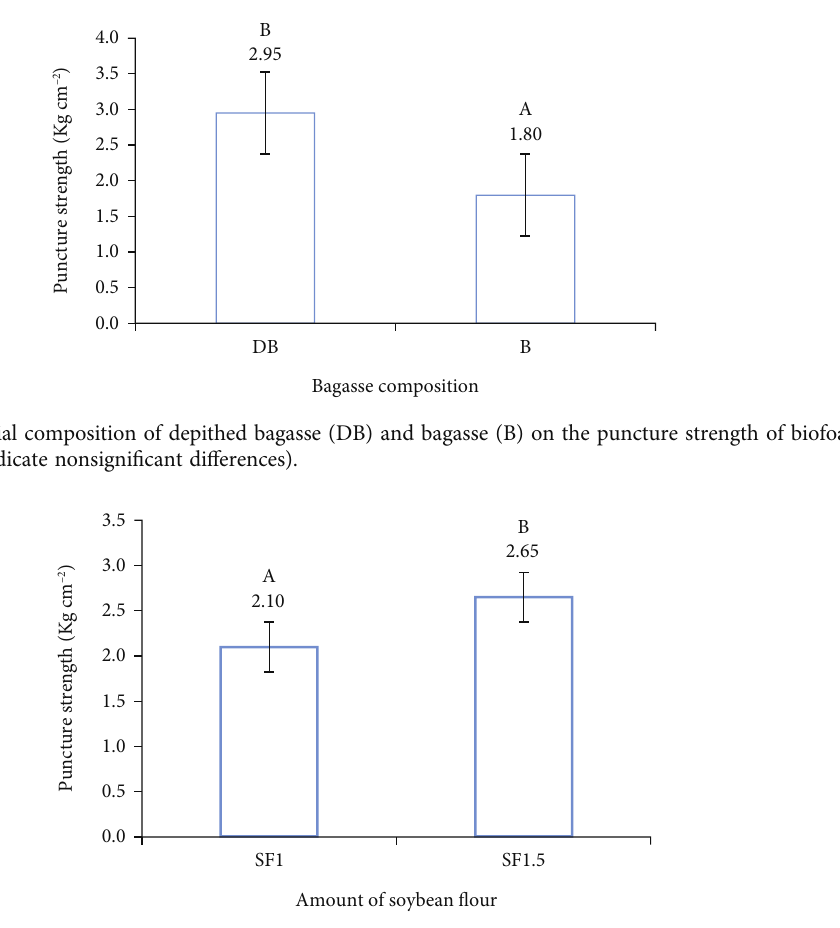
Figure 10: E ff ect of soybean fl our addition ratio to bagasse 1:1 (SF1) and 1.5:1 (SF1.5) on the puncture strength of the biofoam cup (values followed by the same letter indicate nonsigni fi cant di ff erences). Table 1: Compressive strength of biofoam cup. Soybean fl our to Bagasse bagasse